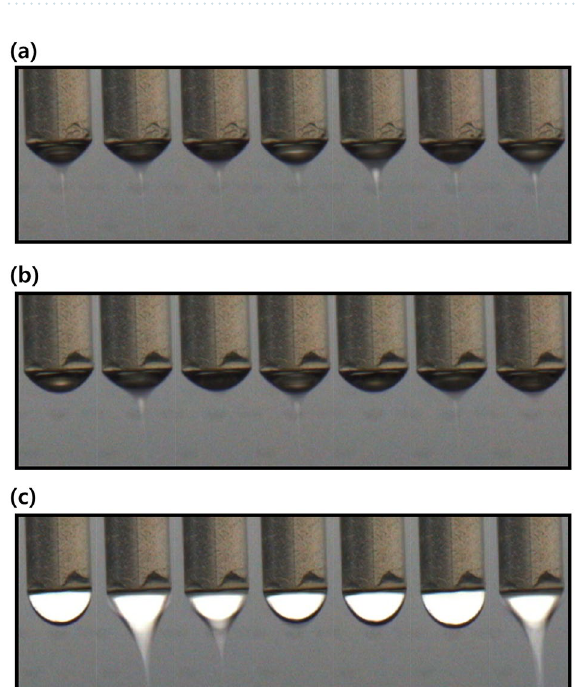
Figure 4. ( a ) Schematic of electrospray process. ( b ) Schematic showing the process of transfer of positive charges in ethanol.